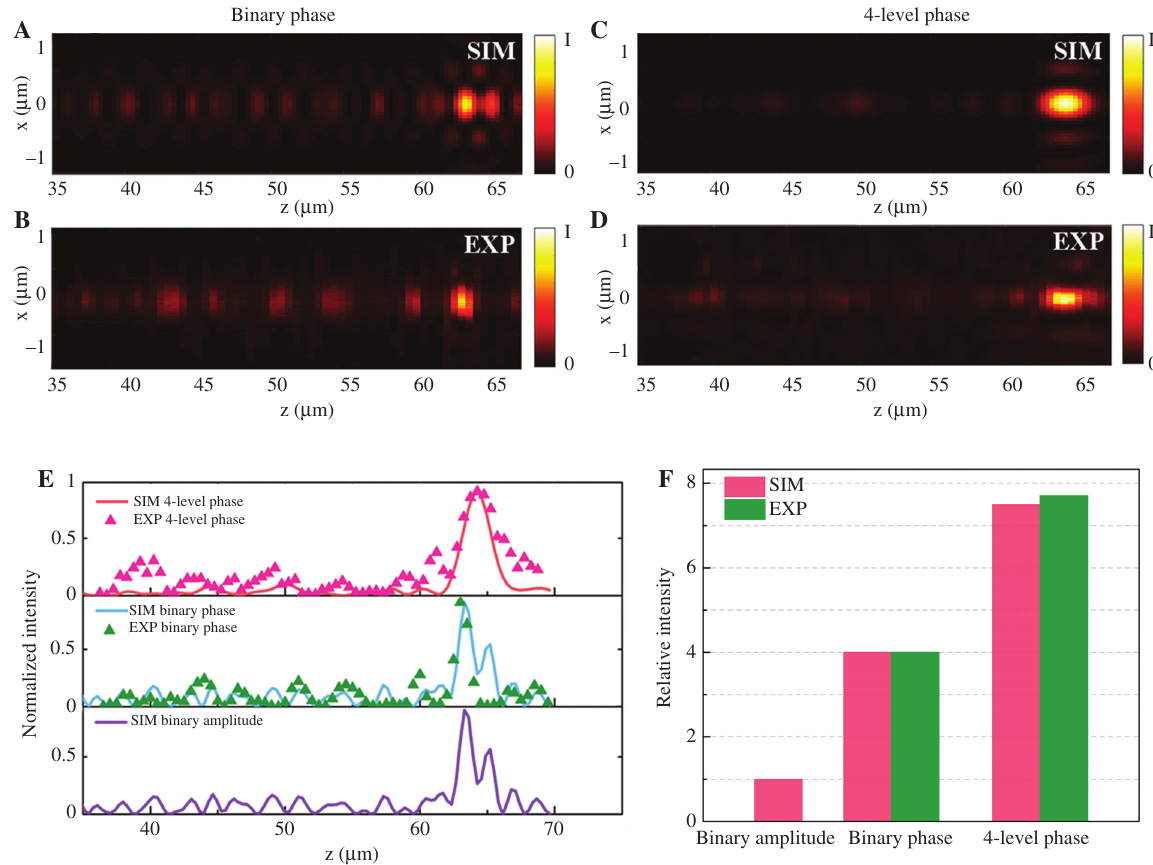
Figure 5: Comparisons between the binary amplitude/phase and the four-level phase-type SCL. (A–D) Simulated (A, C) and experimentally measured (B, D) focal spot intensity distributions in the propagation plane (XOZ plane) for the binary phase-type (A, B) SCL and the four-level phase-type (C, D) SCL, respectively. (E) Line profiles of the transmitted light intensity distribution along the optical axis for three types of SCL. The curves plotted with three different colors represent the simulated intensity distribution along the longitudinal direction for the binary amplitude SCL (purple line), the binary phase SCL (blue line) and the four-level phase (pink line) SCL. The two triangle-dot diagrams represent the experimentally measured results of the binary phase SCL and the four-level phase type SCL, respectively. The related focusing quality of the binary amplitude SCL is only performed with simulation in the diagram for comparison. (F) Comparison of the focal spot intensities for the binary amplitude SCL, the binary phase SCL and the four-level phase-type SCL, which shows that multi-level phase SCL can achieve remarkably high intensity than that for the traditional binary amplitude-type SCL and the binary phase-type